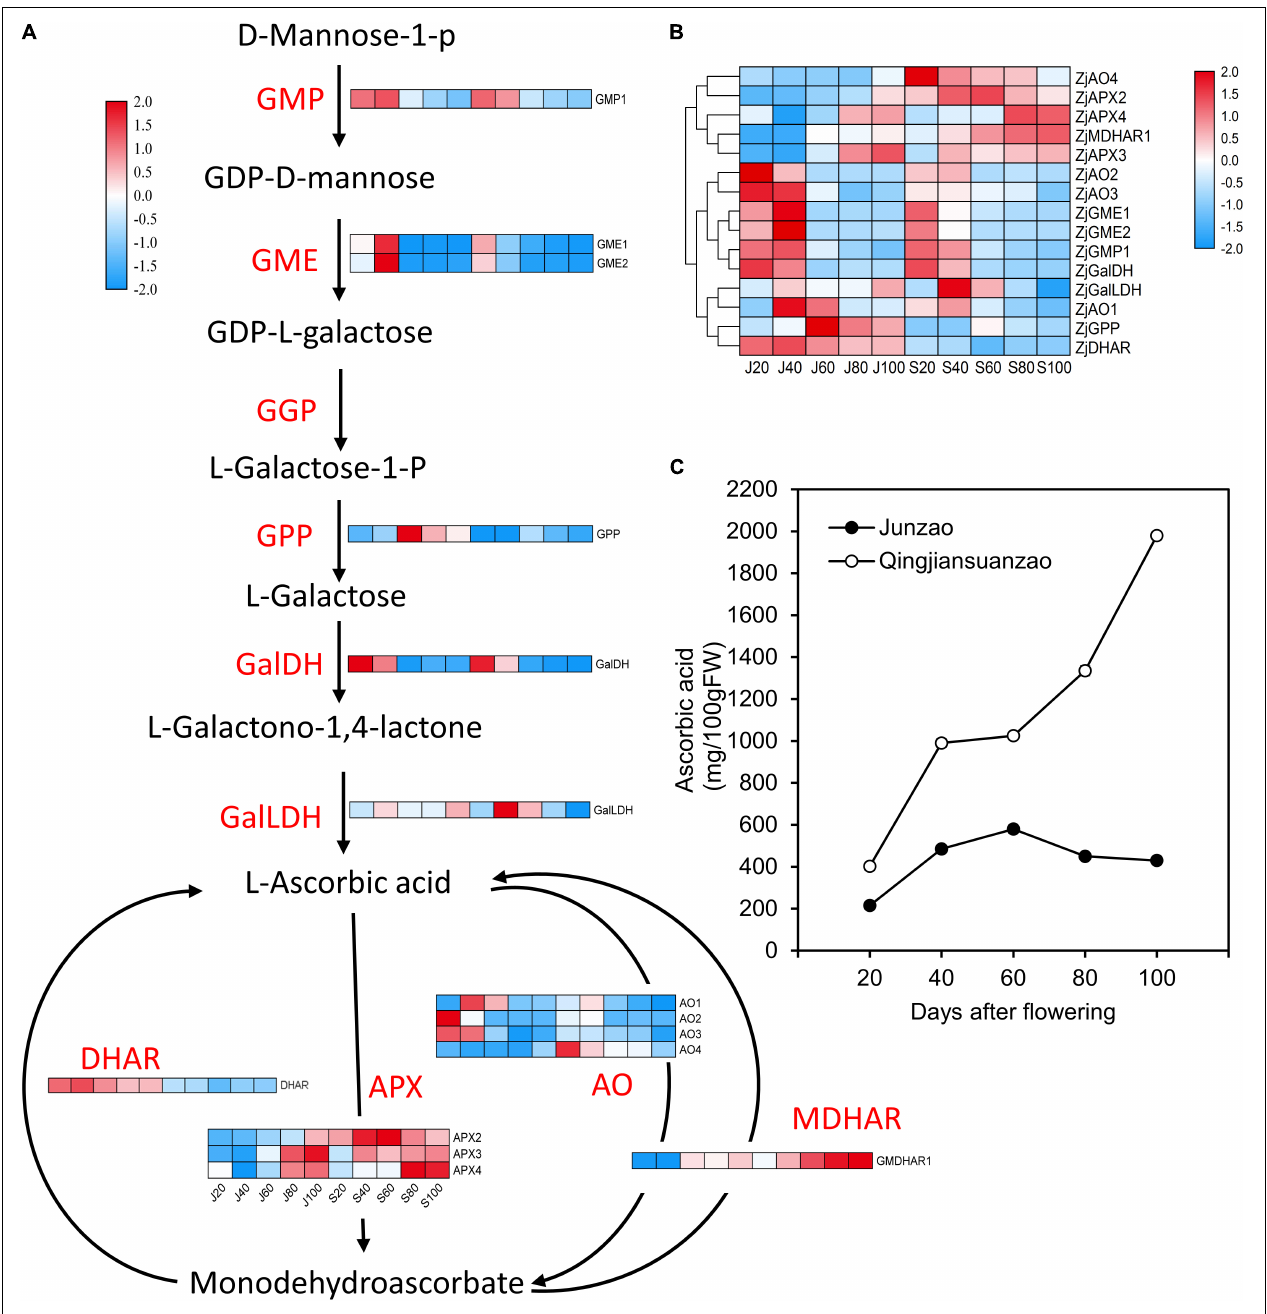
FIGURE 7 | Expression profile of proteins involved in ascorbic acid (AsA) metabolism and the dynamics of AsA contents during fruit development and ripening. (A) Protein expression changes involved in AsA biosynthesis and recycling pathways in jujube fruits. (B) Cluster analysis of proteins involved in AsA metabolism. (C) The AsA contents in jujube fruit development. GMP, GDP-d-mannosepyrophosphorylase; GME, GDP-mannose-3 (cid:48) -5 (cid:48) -epimerase; GGP, GDP-l-galactosetransferase; GPP, l-galactose-1-phosphatephosphatase; GalDH, L-galactose dehydrogenase; GalLDH, L-galactono-1,4-lactone dehydrogenase; APX, ascorbate peroxidase; AO, ascorbate oxidase; DHAR, dehydroascorbate reductase; MDHAR, monodehydroascorbate